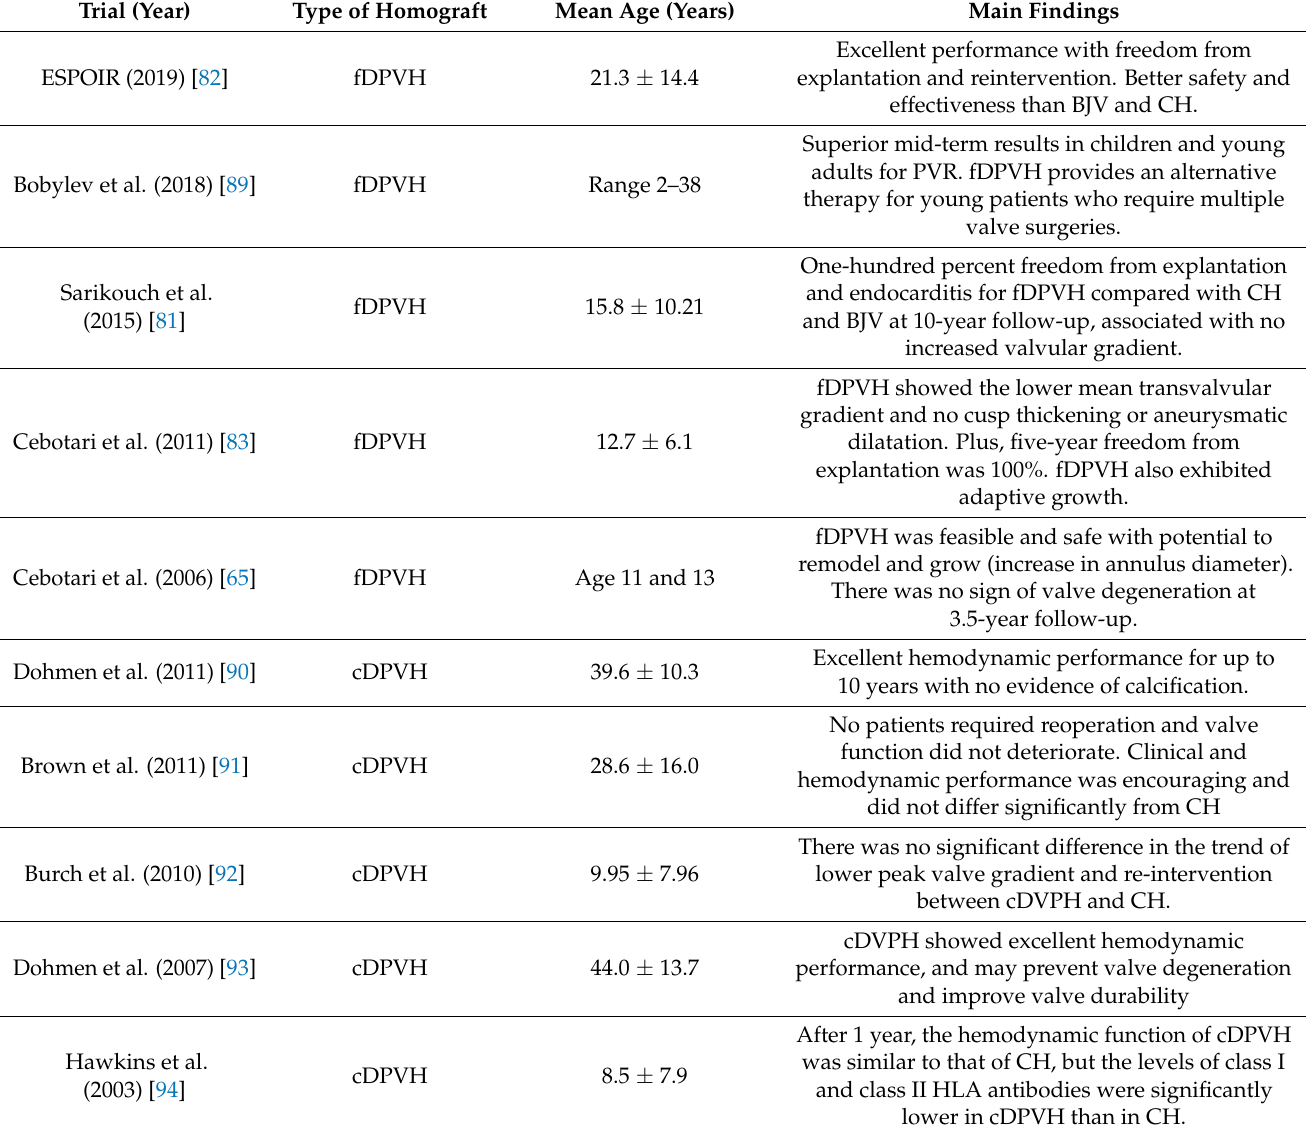
Table 1. Clinical application of decellulized homogeneous pulmonary